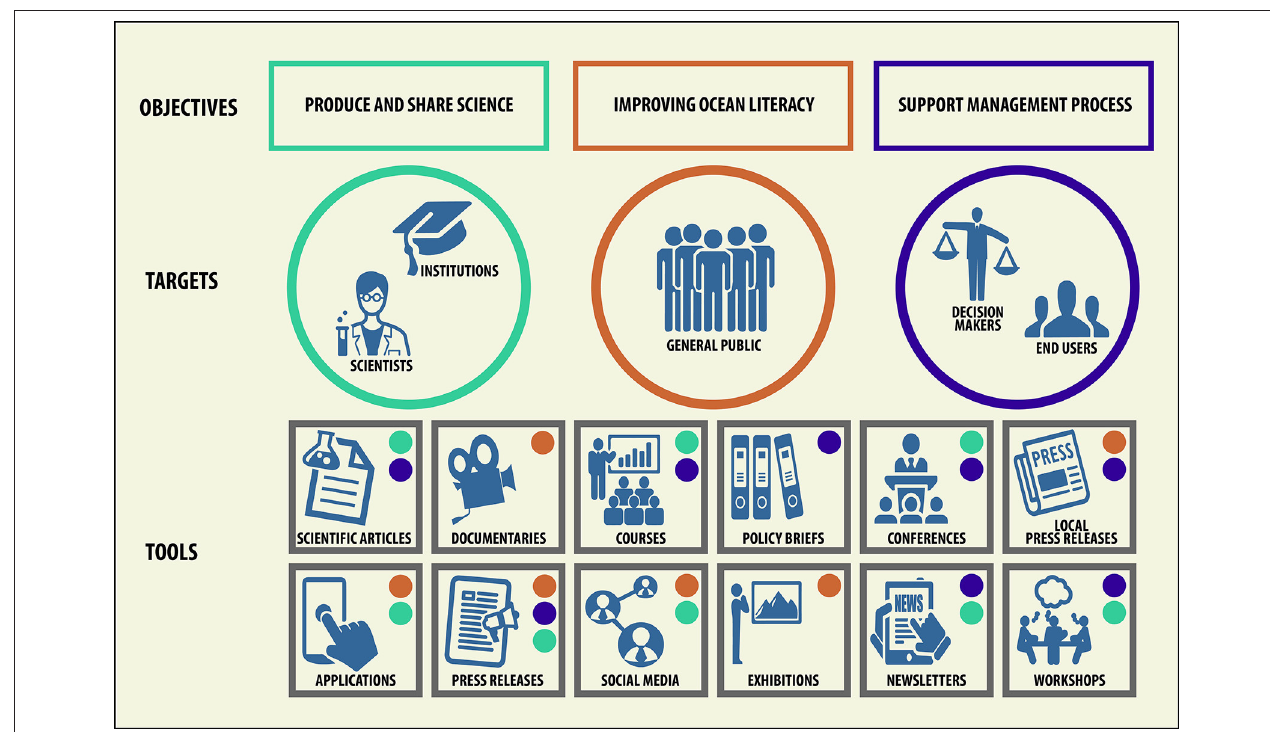
FIGURE 4 | Targeted dissemination tool for each macro audience cluster identified in the DEVOTES stakeholder map. The targets to which each tool is dedicated are reported in order of importance: e.g., scientific articles are mostly directed to scientists (green circle) and secondly to decision makers and end users (blue circle); documentaries are instead mostly directed to the general public (orange